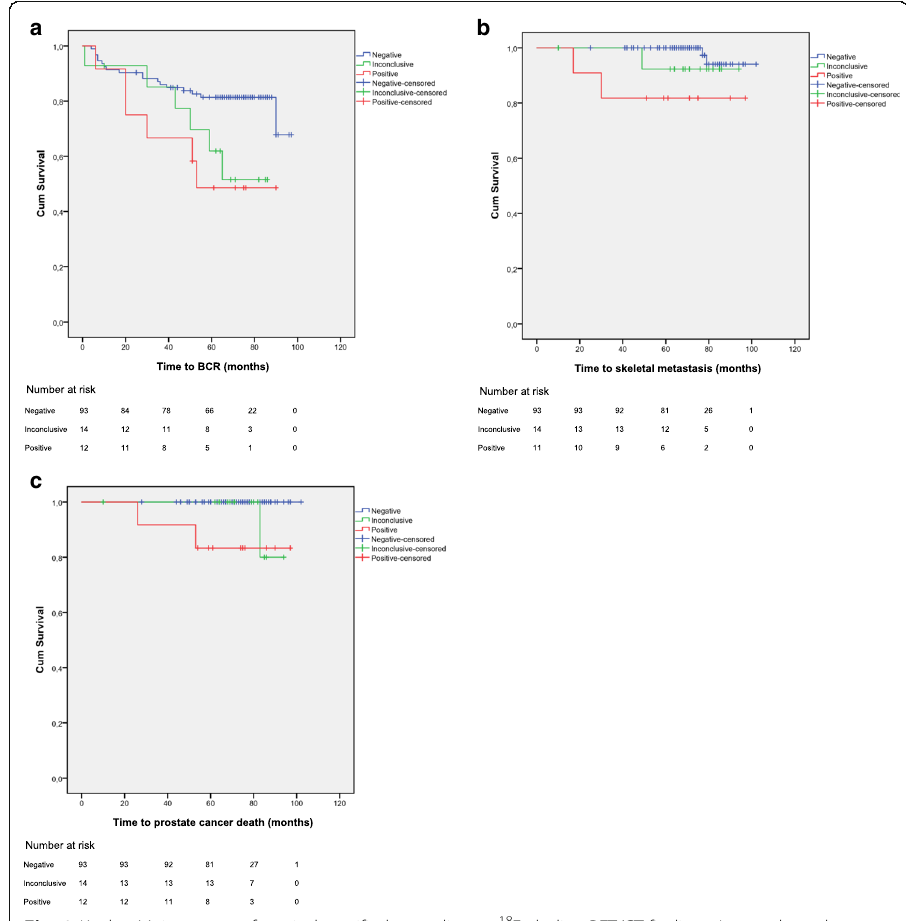
Fig. 2 Kaplan-Meier curves of survival stratified according to 18 F-choline PET/CT findings. Log-rank p -values are shown for differences between men with negative and positive findings. a Time to biochemical recurrence, p =0.02. b Time to skeletal metastasis, p =0.002. One man whose bone metastasis was confirmed by other imaging has been excluded from analysis. c Time to prostate cancer-specific death, p <0.001. Abbreviations: PET/CT, positron emission tomography fused with computed tomography; BCR, biochemical